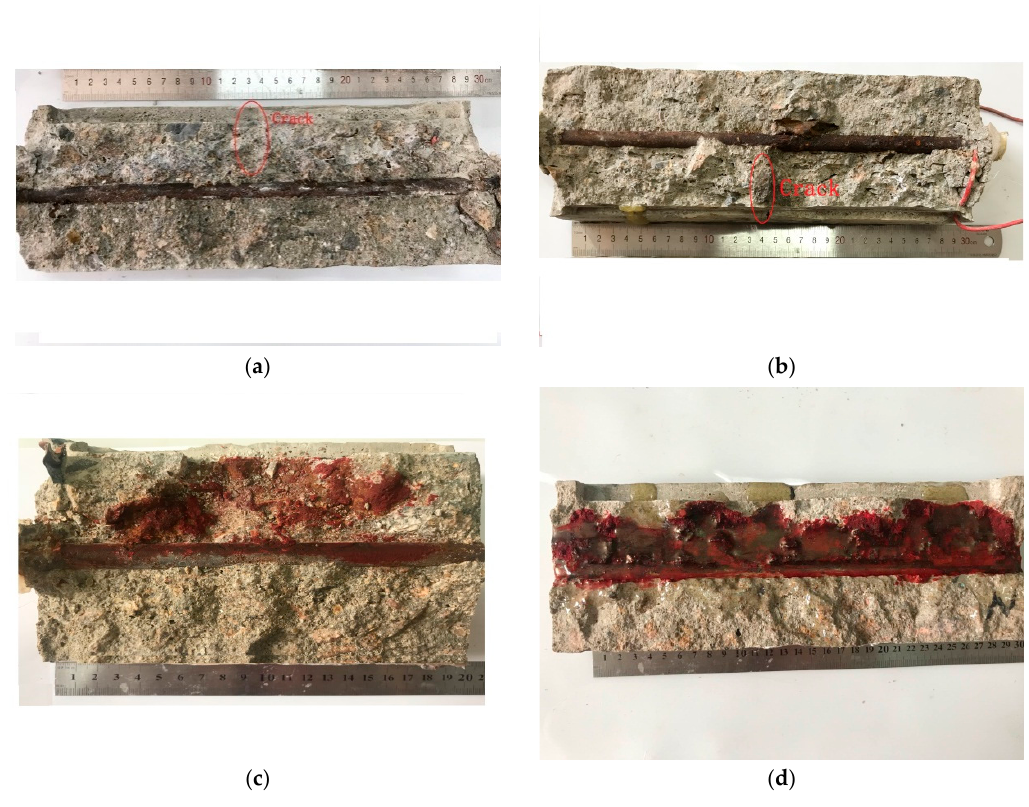
Figure 12. Pictures of concrete samples (LC) with transverse crack widths. ( a ) Crack width (LC) = 0.10 mm; ( b ) Crack width (LC) = 0.15 mm; ( c ) Crack width (LC) = 0.20 mm; ( d ) Crack width (LC) = 0.30 mm.